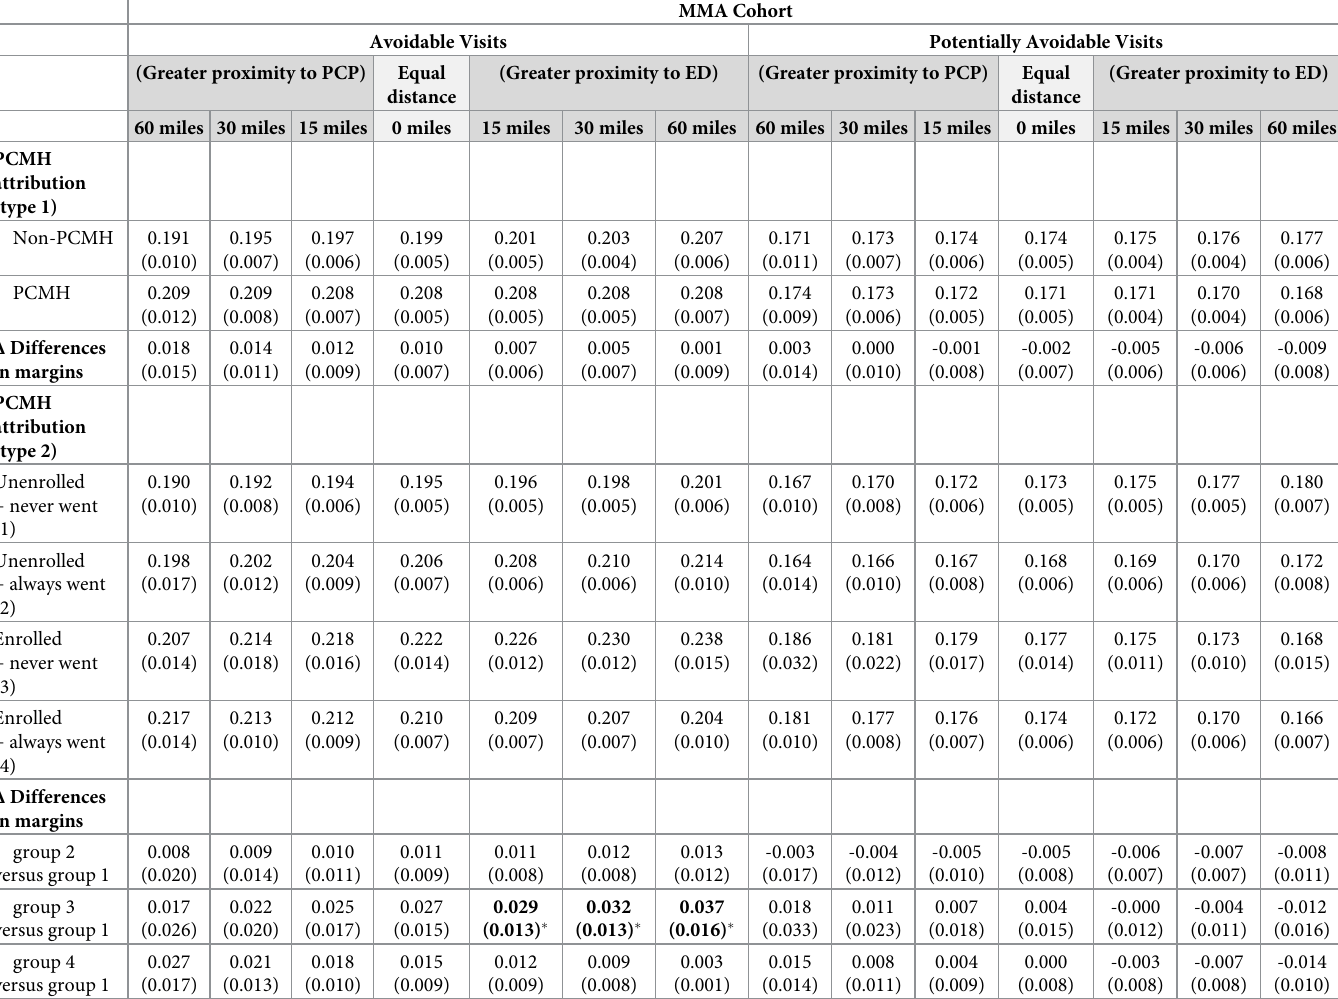
Table 5. Comparisons of predicted probabilities in ED visits for MMA outcomes by medical home attribution type after accounting for geographic proximity to providers. MMA Cohort Avoidable Visits Potentially Avoidable